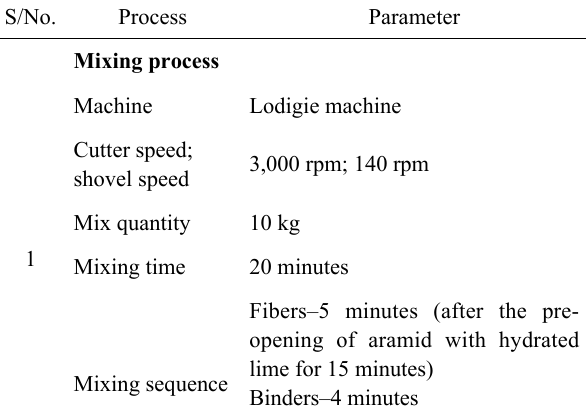
Table A1 Manufacturing methodology.